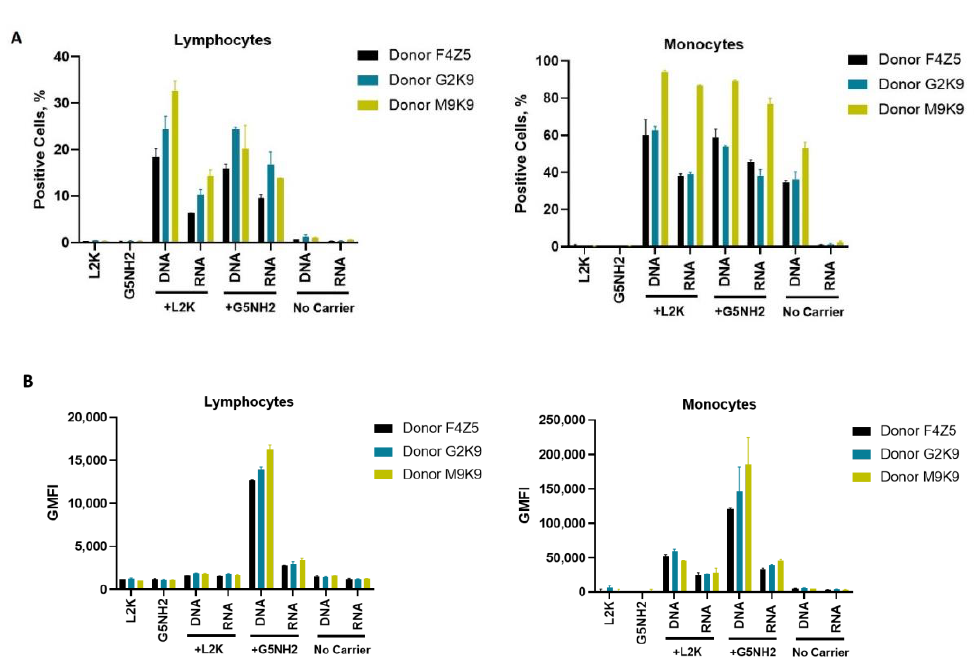
Figure 6. Correlation analysis of cytokine response. The data from the multiplex cytokine analysis including those pre- sented in Figure 5 were analyzed using the GraphPad Prism software to determine a correlation or lack thereof between individual cytokines. ( A ) The Pearson correlation matrix assumes a Gaussian distribution (parametric analysis). In this analysis, values between ±0.5 and ±1 refer to a high degree of correlation, whereas values close to ±1 mean perfect correlation; negative values (in red) refer to the negative correlation, whereas positive values (in blue) mean positive correlation. ( B ) The Spearman correlation matrix assumes no Gaussian distribution (non-parametric analysis). In this analysis, values of ±1 mean perfect correlation; the closer the value is to zero, the weaker the association is; negative values (in red) and positive values (in blue) refer to the negative and positive correlation, respectively.